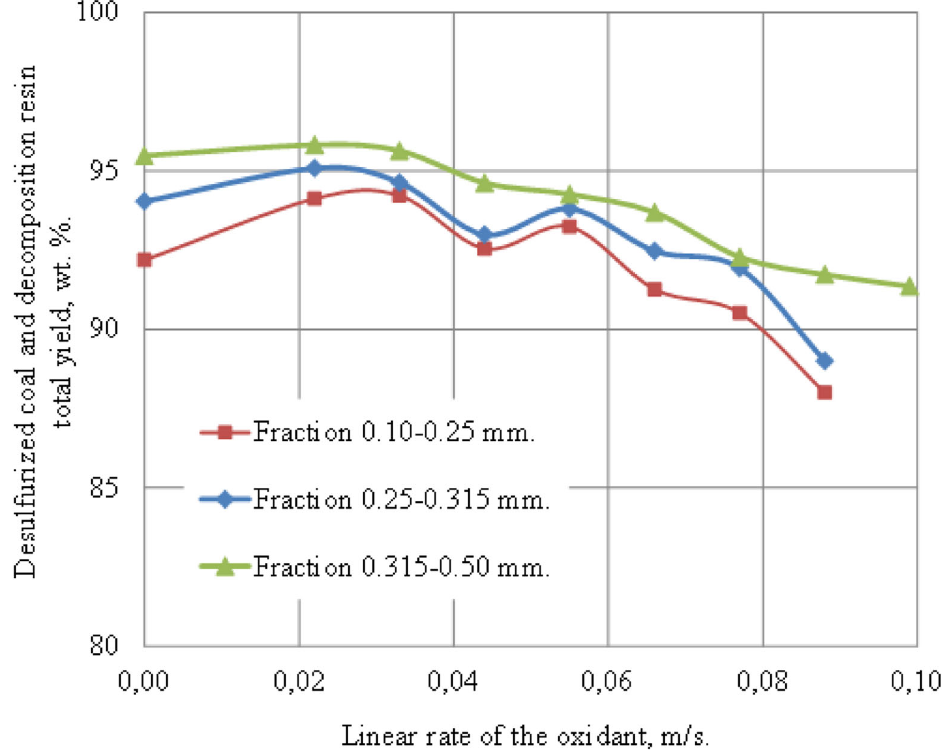
Fig. 4 Desulphurized coal and decomposition resin total yield versus OLV and coal particles’